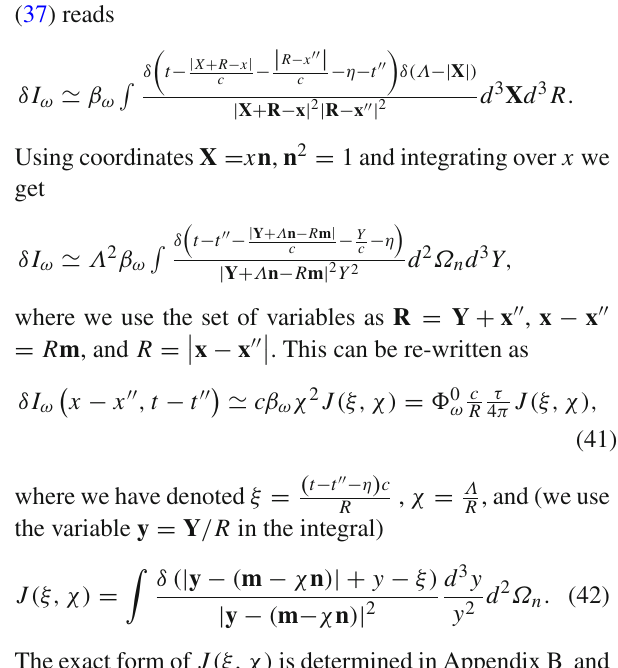
First, we consider the tail for the scattering by normal matter χ = 0. This case can be considered as the limit when the distance between entrances into the same wormhole tends to zero Λ = | R + − R − | → 0 which means that scattered radiation comes from the same point where it was